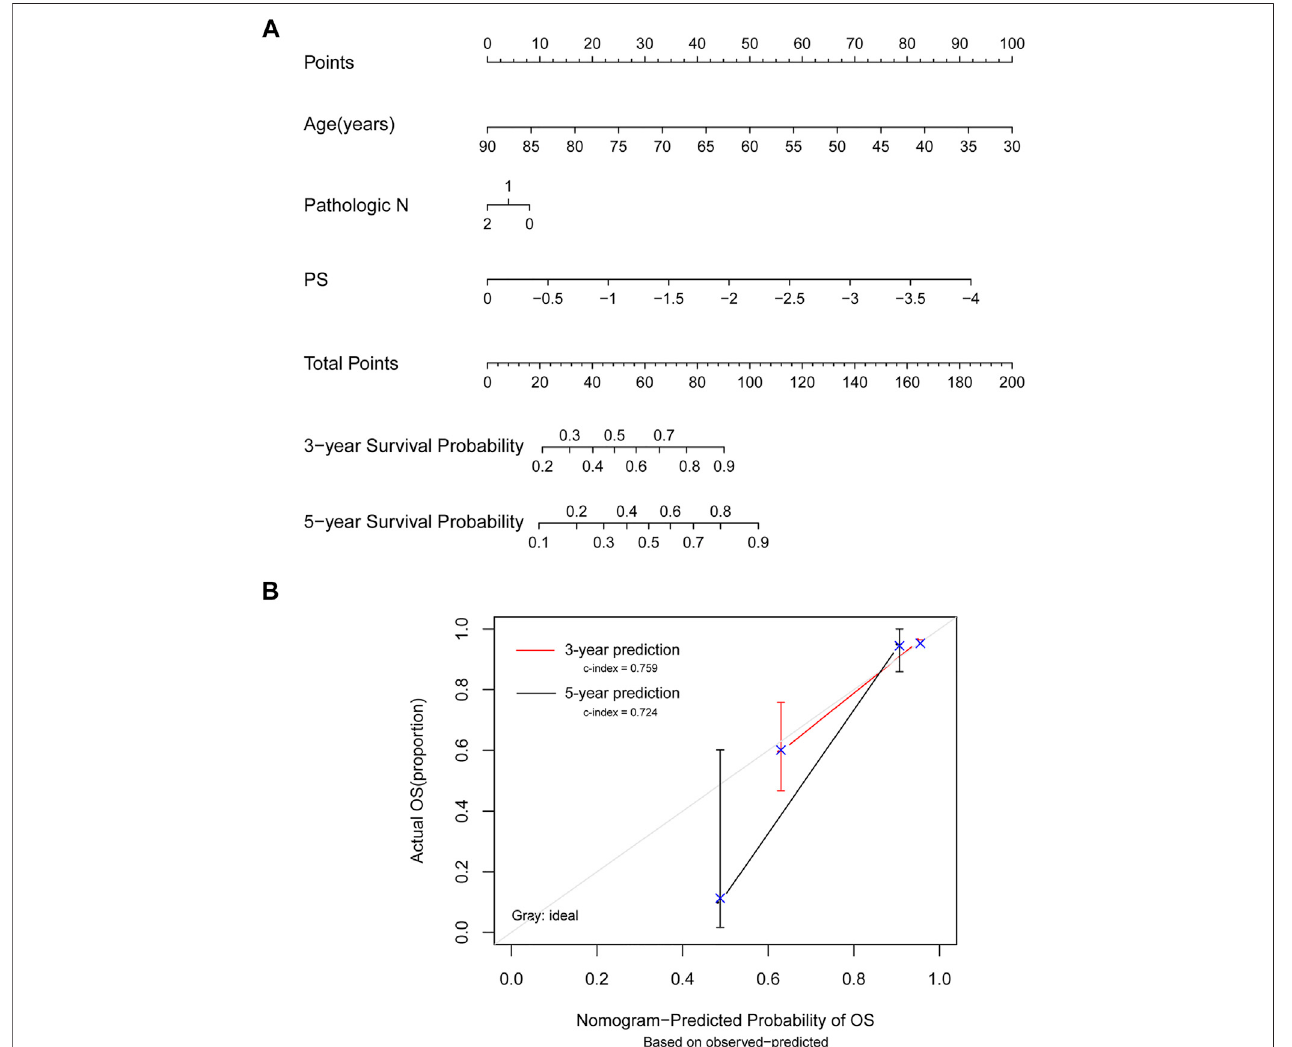
FIGURE 6 | Model comparison analyses. (A) Nomogram survival rate prediction model for independent prognostic factors. (B) A 3-year and 5-year survival rate prediction line graph and an actual survival rate consistency line graph. The horizontal axis shows the predicted OS rate, the vertical axis shows the actual OS rate, and the red and black lines show 3- and 5-year predicted line graphs,